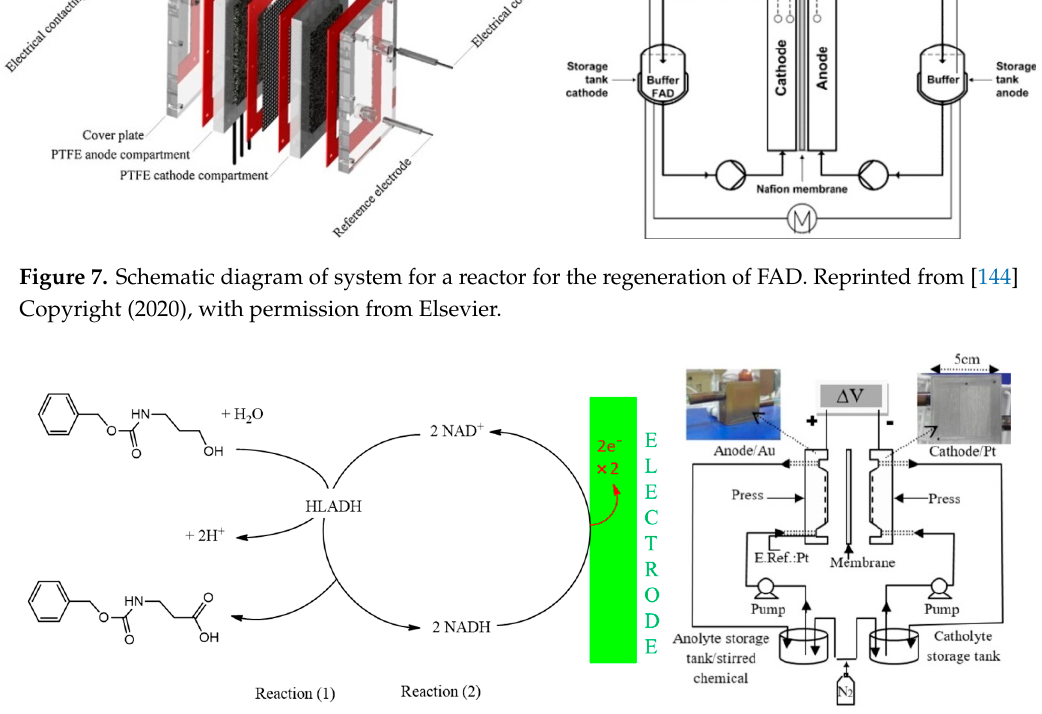
Figure 7. Schematic diagram of system for a reactor for the regeneration of FAD. Reprinted from [144]